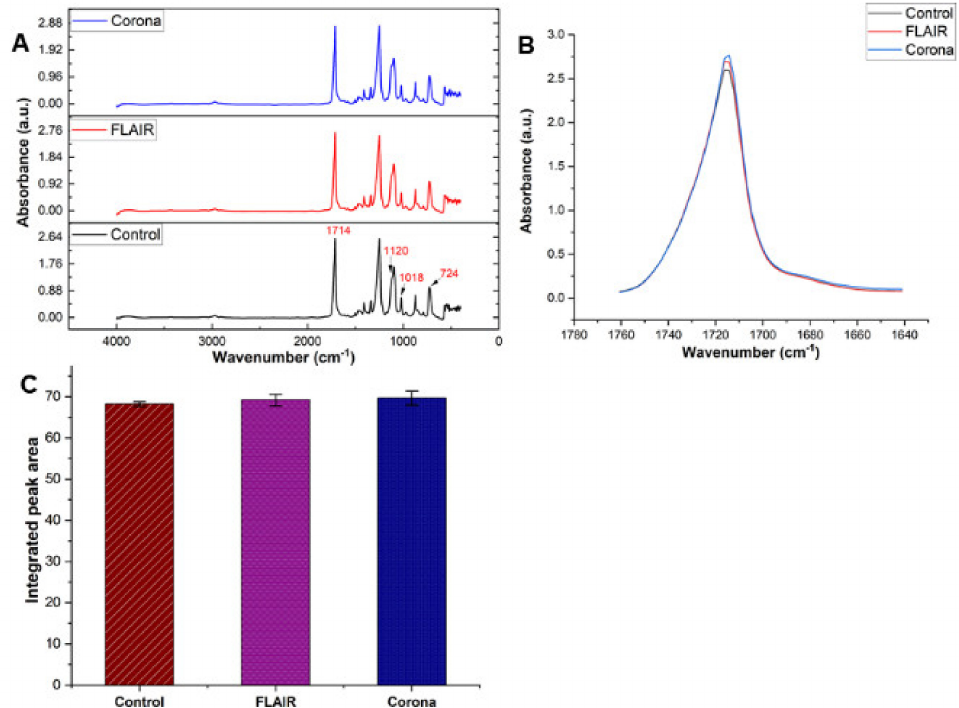
Figure 5. ATR-IR results of plasma-treated and untreated PET films: ( A ) Full IR spectra for the three samples, ( B ) Carbonyl region spectra (1650–1750 cm − 1 ), and ( C ) Integrated peak area of carbonyl